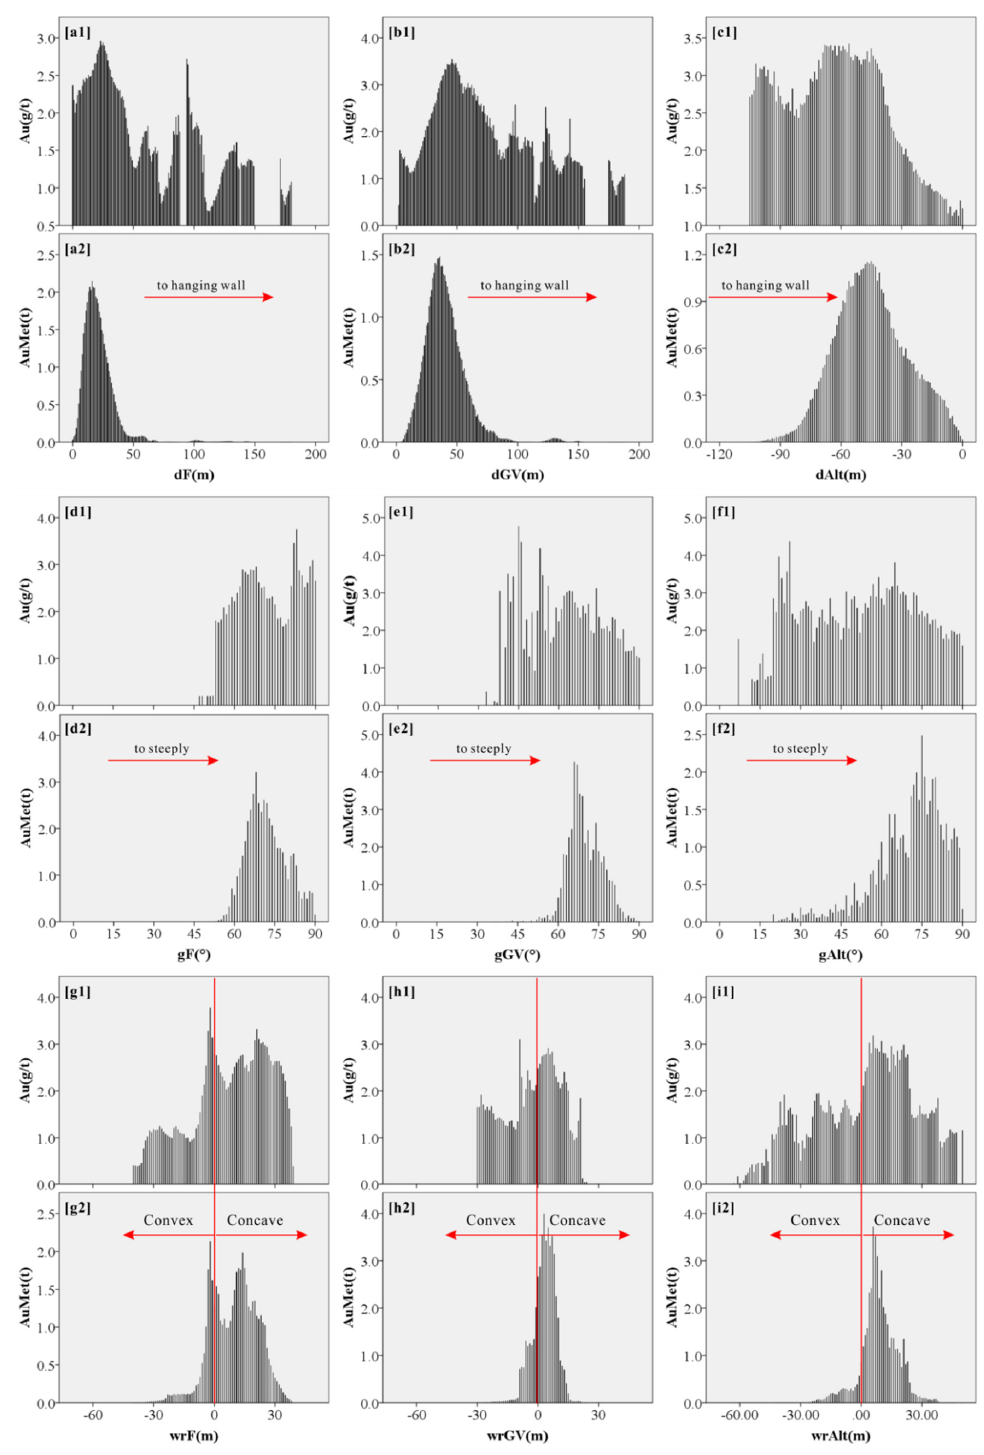
Figure 7. Bar charts of geological features and mineralization indexes. ( a ) d F v.s. Au and AuMet; ( b ) d GV v.s. Au and AuMet; ( c ) d Alt v.s. Au and AuMet; ( d ) g F v.s. Au and AuMet; ( e ) g GV v.s. Au and AuMet; ( f ) g Alt v.s. Au and AuMet; ( g ) wr F v.s. Au and AuMet; ( h ) wr GV v.s. Au and AuMet; ( i ) wr Alt v.s. Au and AuMet. Au stands for the gold grade, and AuMet is the gold resource summation of all ore voxels in the same factor